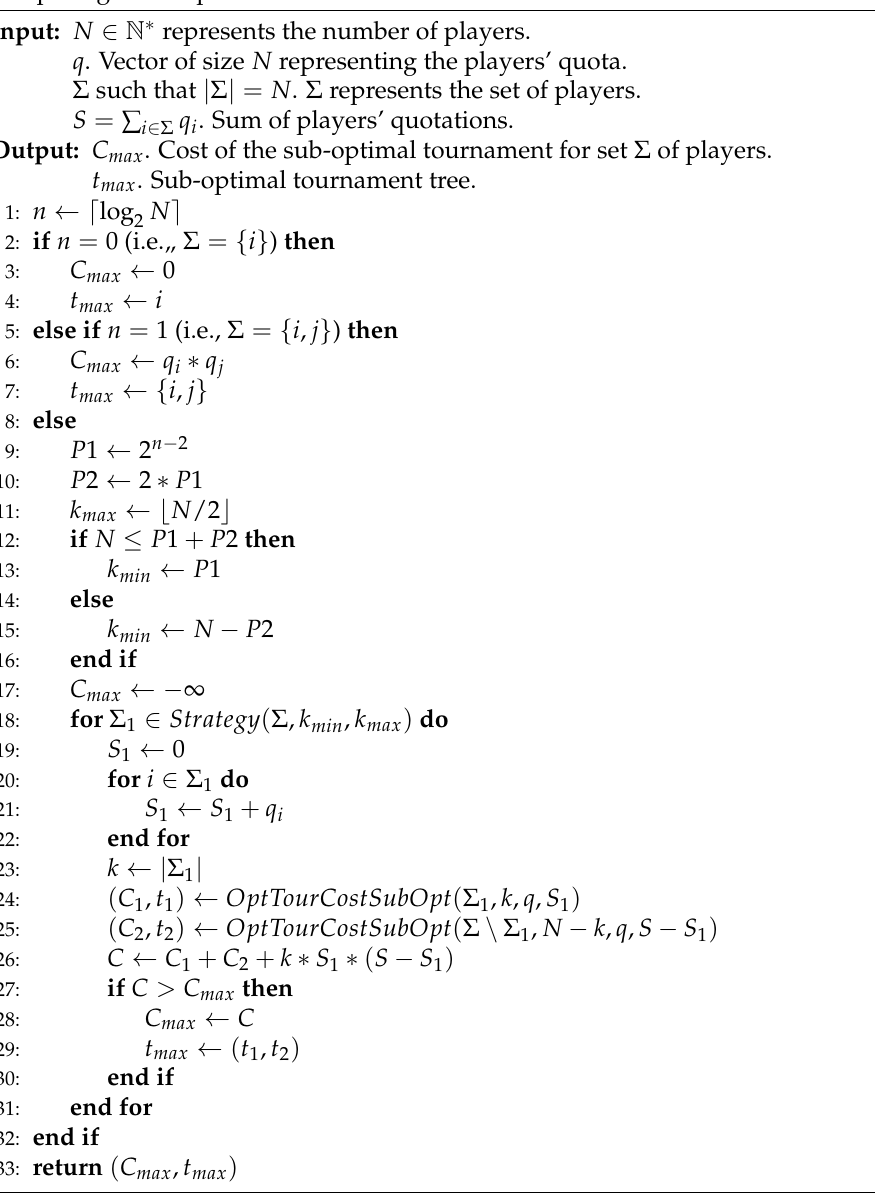
Algorithm 4 OptTourCostSubOpt ( Σ , N , q , S ) top-down divide-and-conquer algorithm for computing a sub-optimal